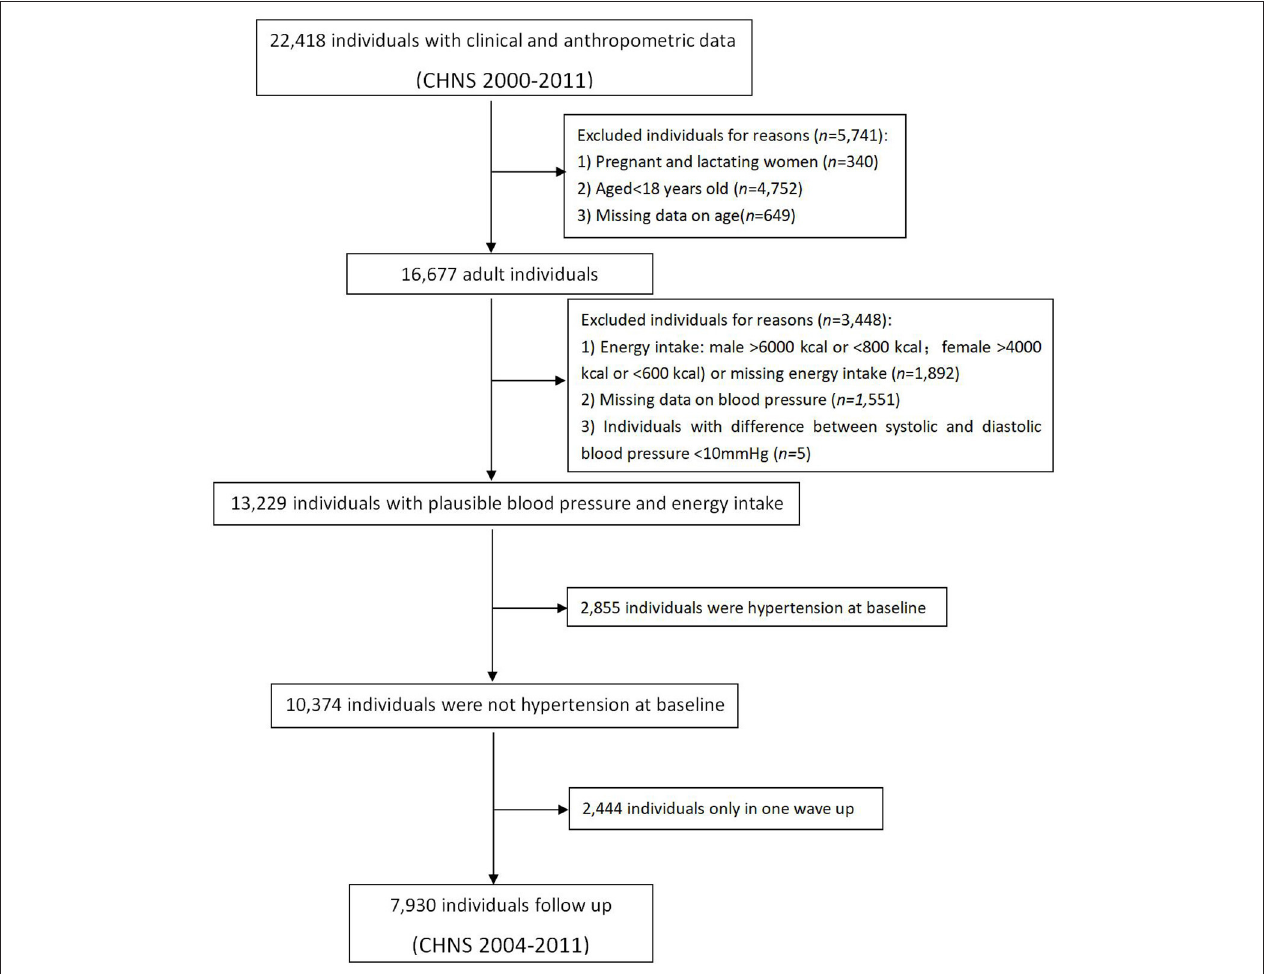
FIGURE 1 | Flow chart illustrating the sample selection procedure.